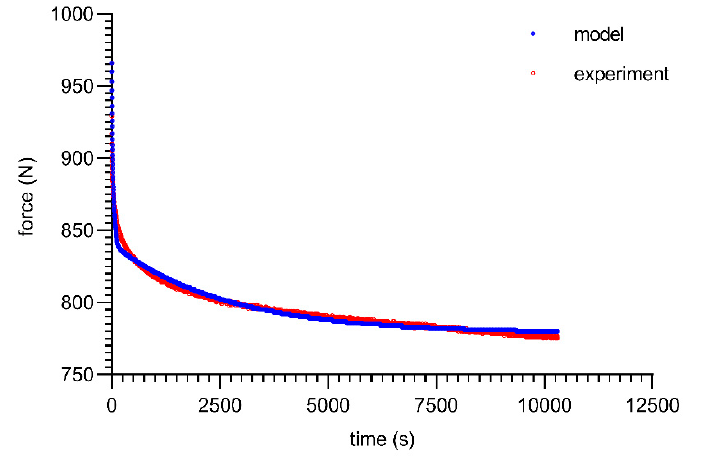
Figure 8. Material 80 ShA—five-parameter relaxation model and experimental data for ε = 25% .